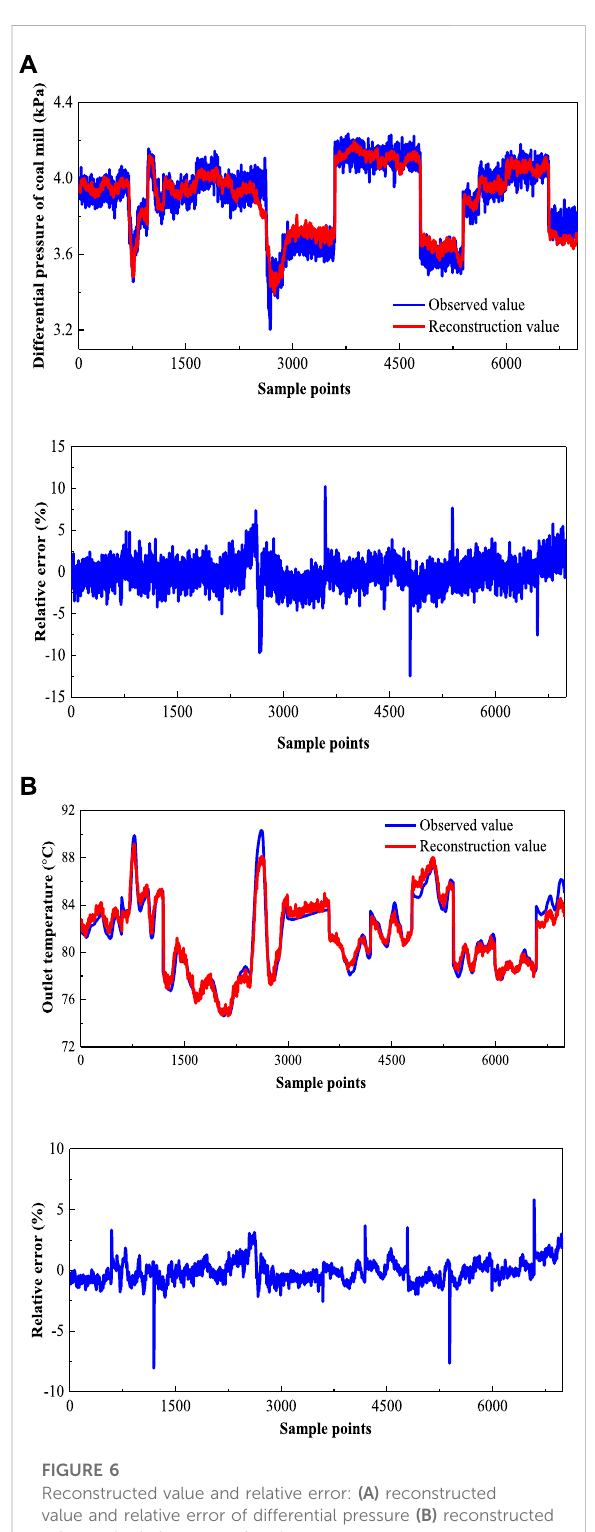
FIGURE 6 Reconstructed value and relative error: (A) reconstructed value and relative error of differential pressure (B) reconstructed value and relative error of outlet